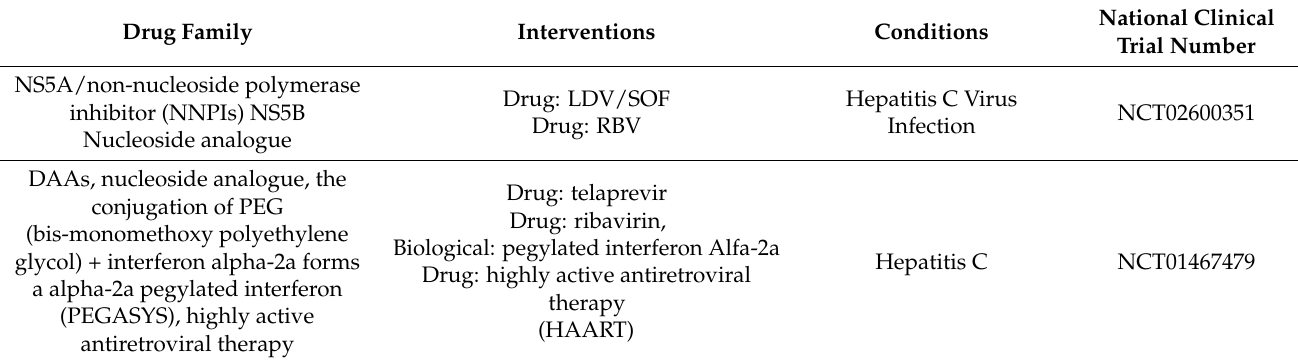
Table 4. Phase 3 interventional studies for HCV treatment terminated with results, drug family, and conditions. Drug